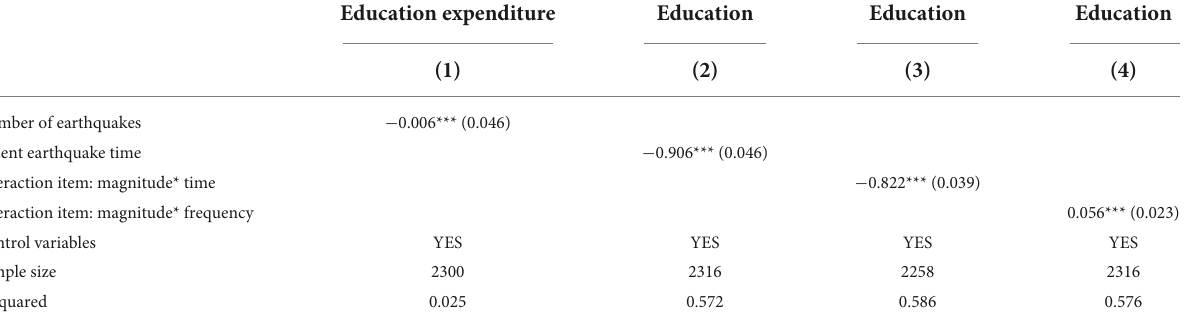
TABLE 6 Robustness test: earthquakes and